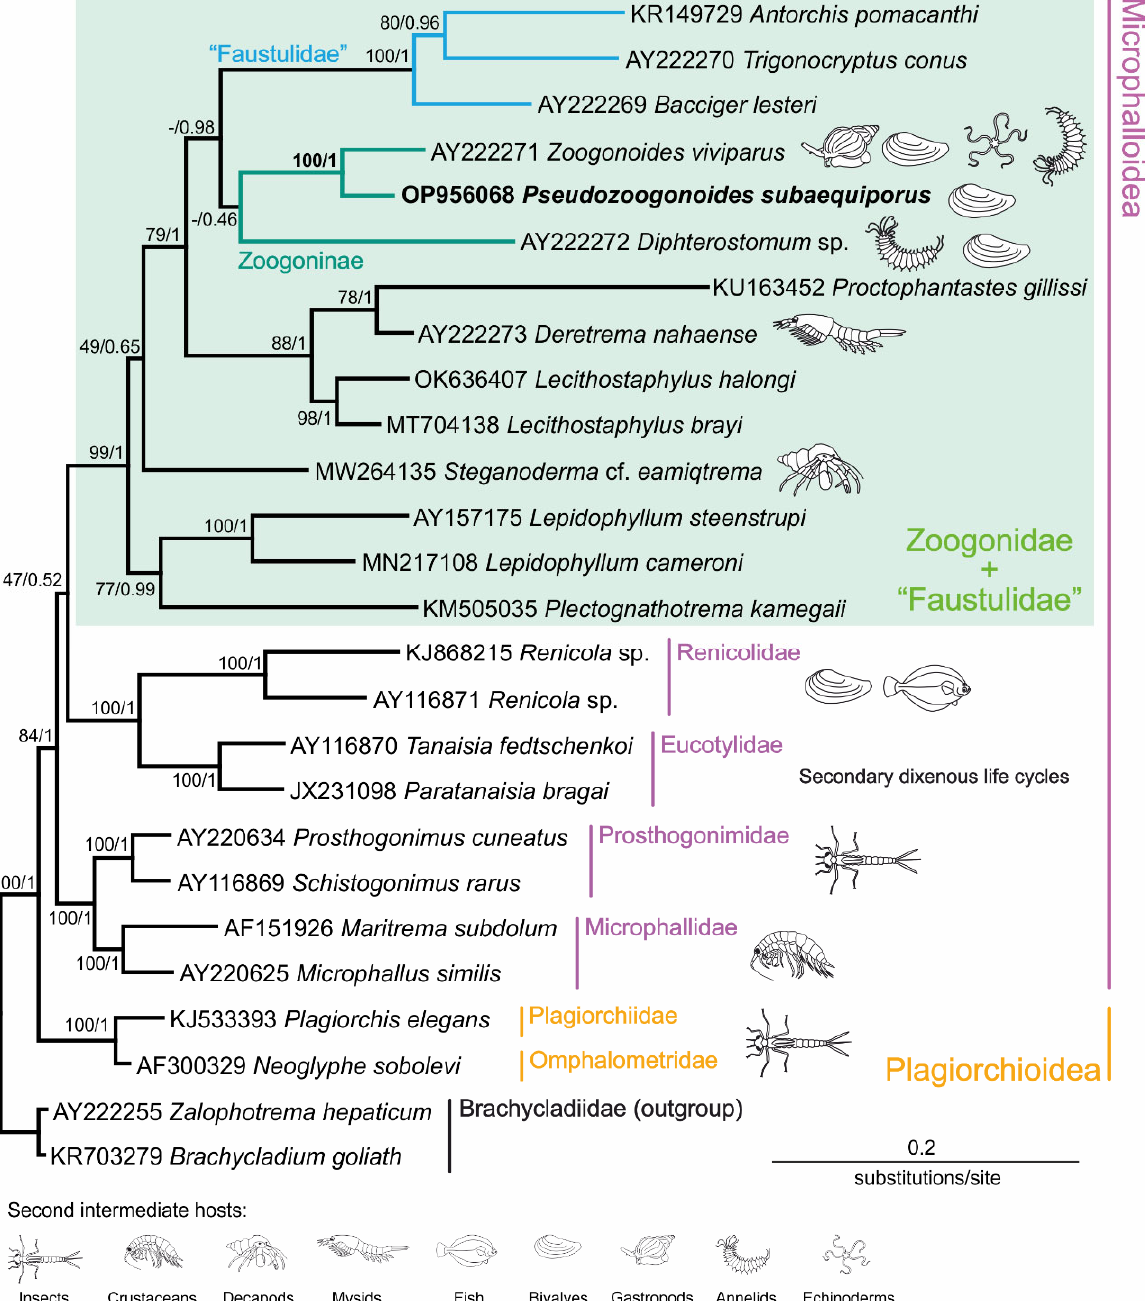
Figure 2. Phylogenetic position of Pseudozoogonoides subaequiporus (indicated in bold) based on 28S rDNA sequence data analysis inferred with Bayesian inference (BI) and maximum likelihood (ML). Nodal support: ML/BI. Scale bar shows the substitution rate. Table 2. Isolates of putative and identified Zoogonidae from the White Sea, their origin and Gen ‐ Bank accession numbers.